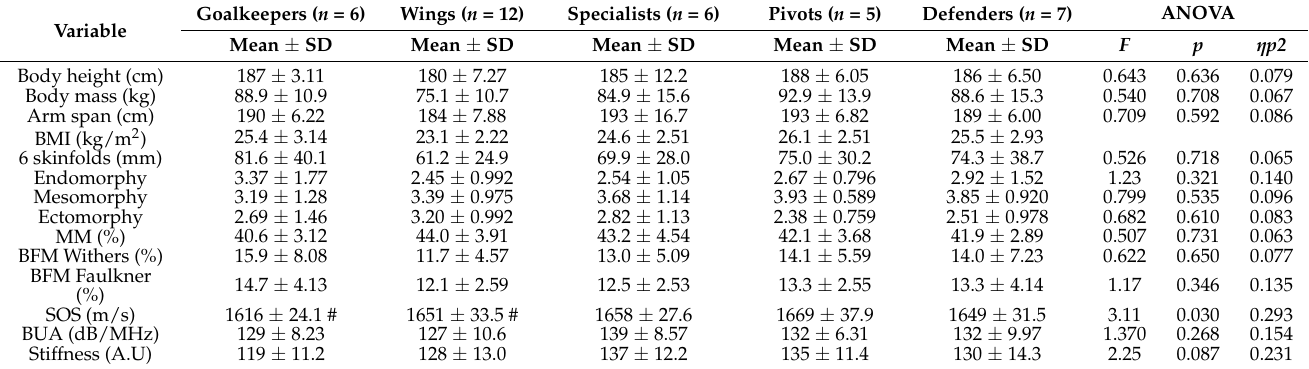
Table 6. Position-related differences in selected anthropometric characteristics, body composition and somatotype compo- nents of male and female